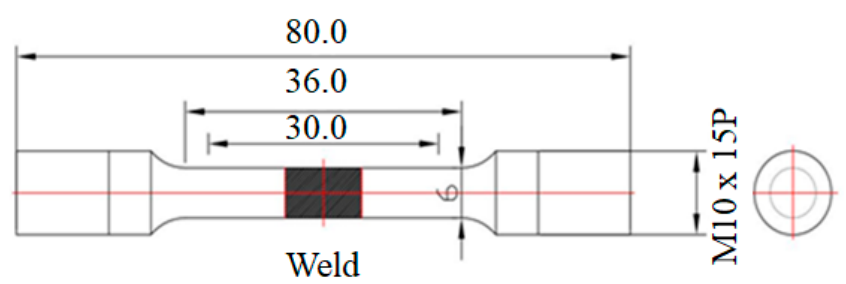
Figure 6. Specimen for mechanical property test.